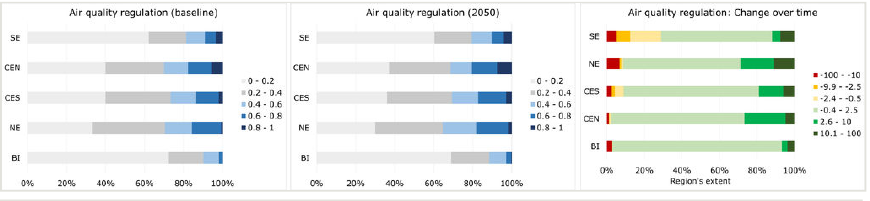
Figure 7. From left to right, air quality regulation for the baseline, the 2050 and as percent change over time. The scores are shown in relation to the percent extent of fi ve European regions, de fi ned after grouping the 28 Member States (MS) according to their climatic characteristics (Ciscar Martinez et al. 2011). The chart on the right shows the percent change over time in the predicted air quality regulation, for the same set of regions. In all charts, the y-axis shows the di ff erent regions (SE: South Europe; CEN: Central Europe North; CES: Central Europe South; NE: North Europe; BI: British Isles). See Suppl. material 3 for a grouping of MS within each region. See main text for additional